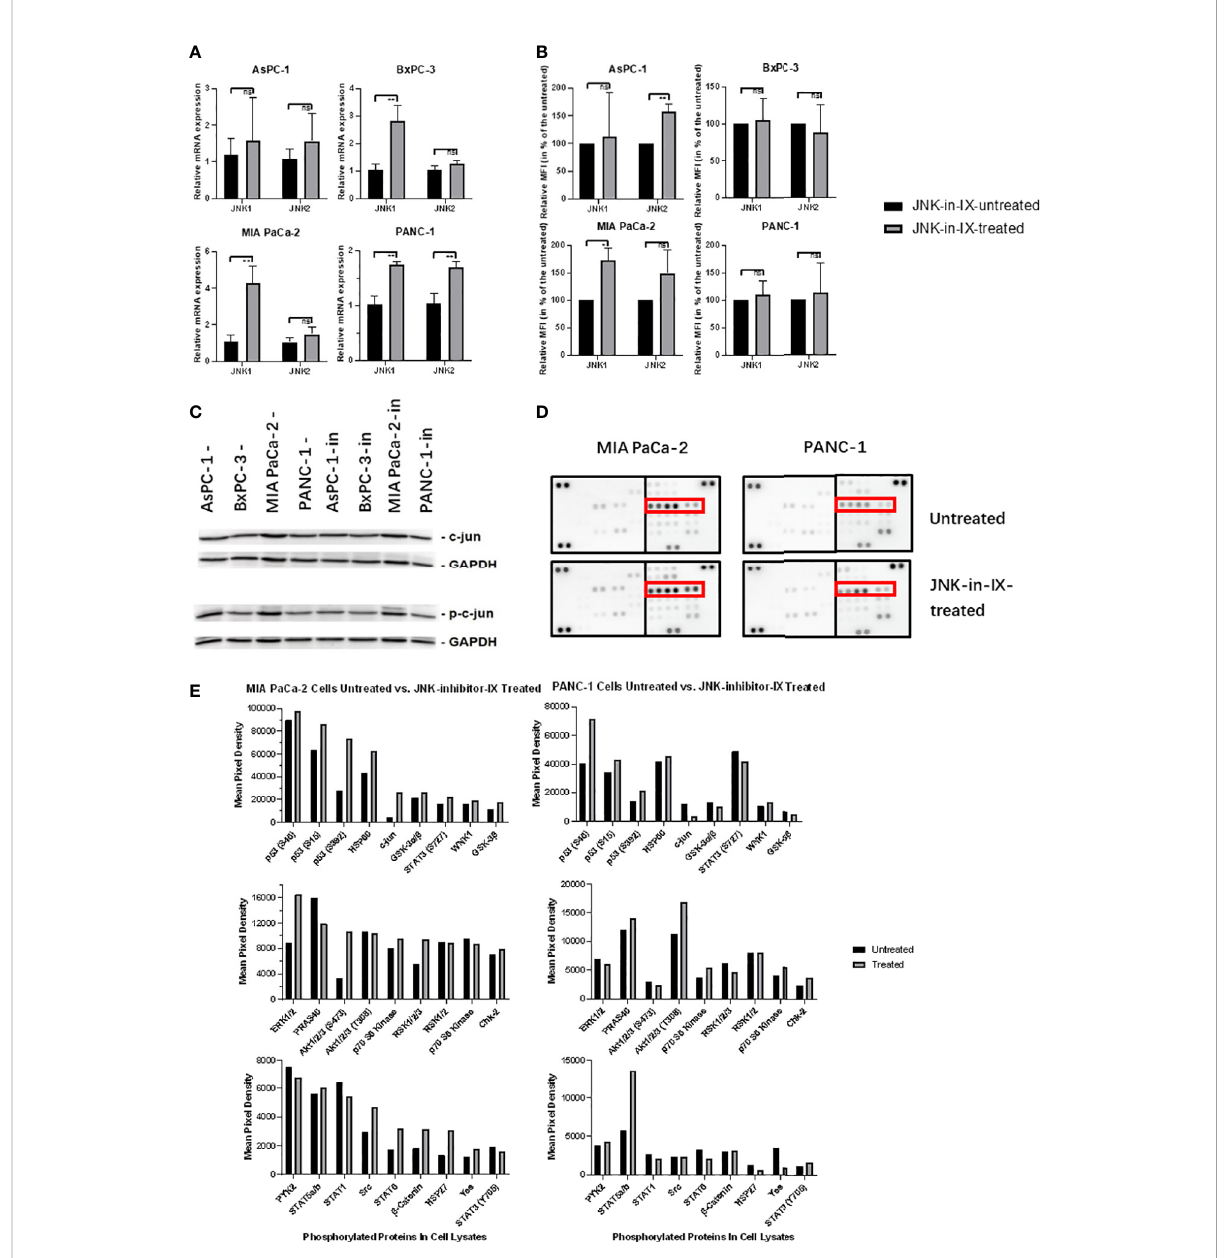
FIGURE 6 Target effectors of JNK-in-IX. (A, B) Relative mRNA expression in qPCR (A) and Mean Fluorescence Intensity (MFI) detected by fl ow cytometry (B) of JNK1 and JNK2 with or without JNK-in-IX treatment. Data shown are the means (±SEM) from 3 (A) and 4 (B) independent experiments. (C) Immunoblot analysis of total expression and phosphorylation of c-jun with or without JNK-in-IX treatment. GAPDH acts as internal control. (D, E) Human Phospho-Kinase Array. Pictures shown are the blots of respective protein phosphorylation with or without JNK-in-IX treatment, p53 phosphorylation is marked in red (D) . (E) Quantitative expression of phosphorylated kinases. Data are shown as mean pixel density. ns p>0.05, *p<0.05,